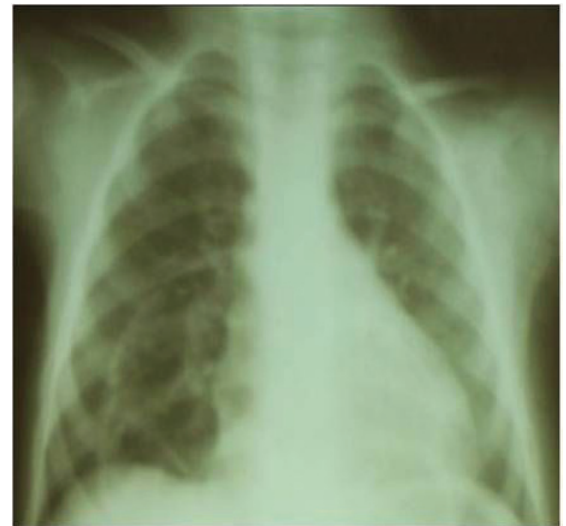
Figure 2. Lateral chest radiography confirms bowel loops